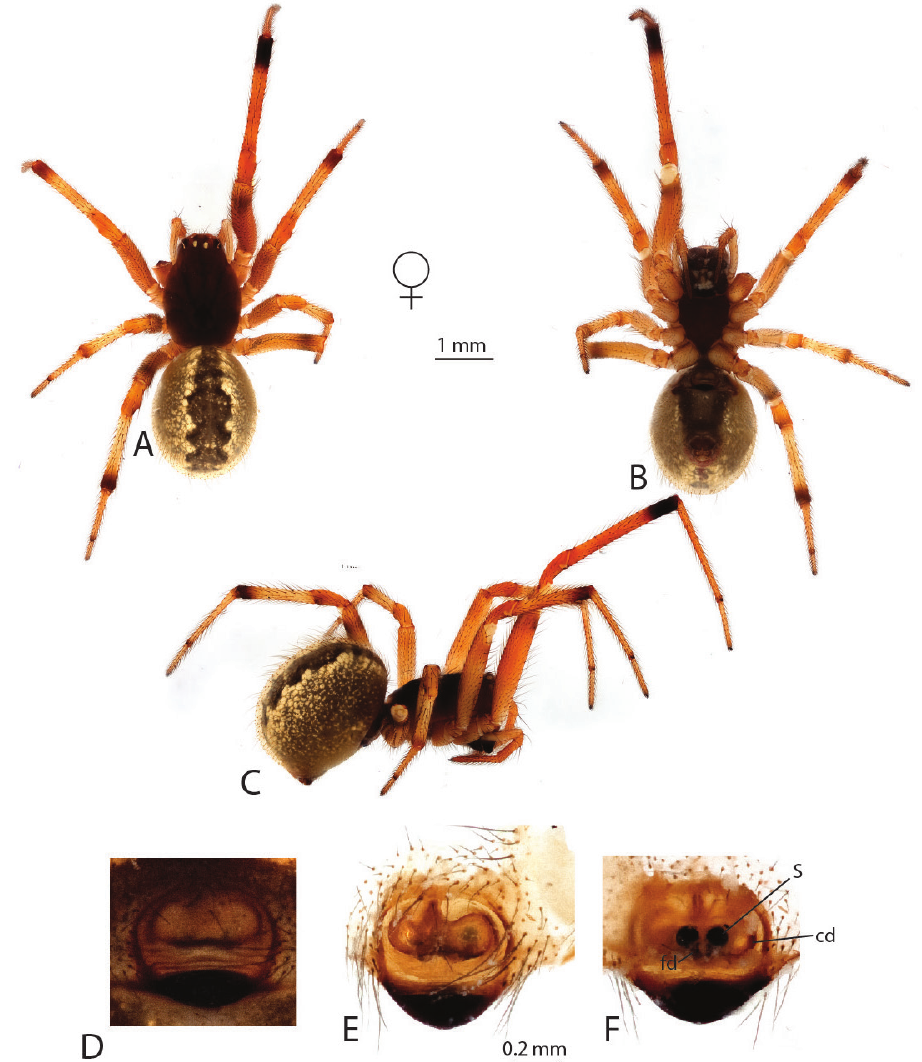
Figure 14. Anelosimus huxleyi : A–C female dorsal, ventral and lateral views D epigynum ventral view E–F cleared epigynum ventral,